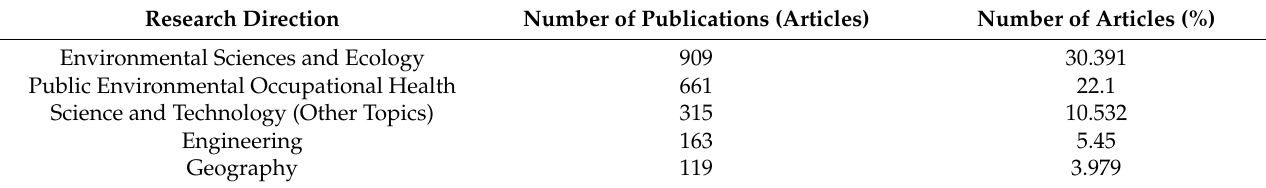
Table 4. Subject direction statistics of rural human settlement environment research.